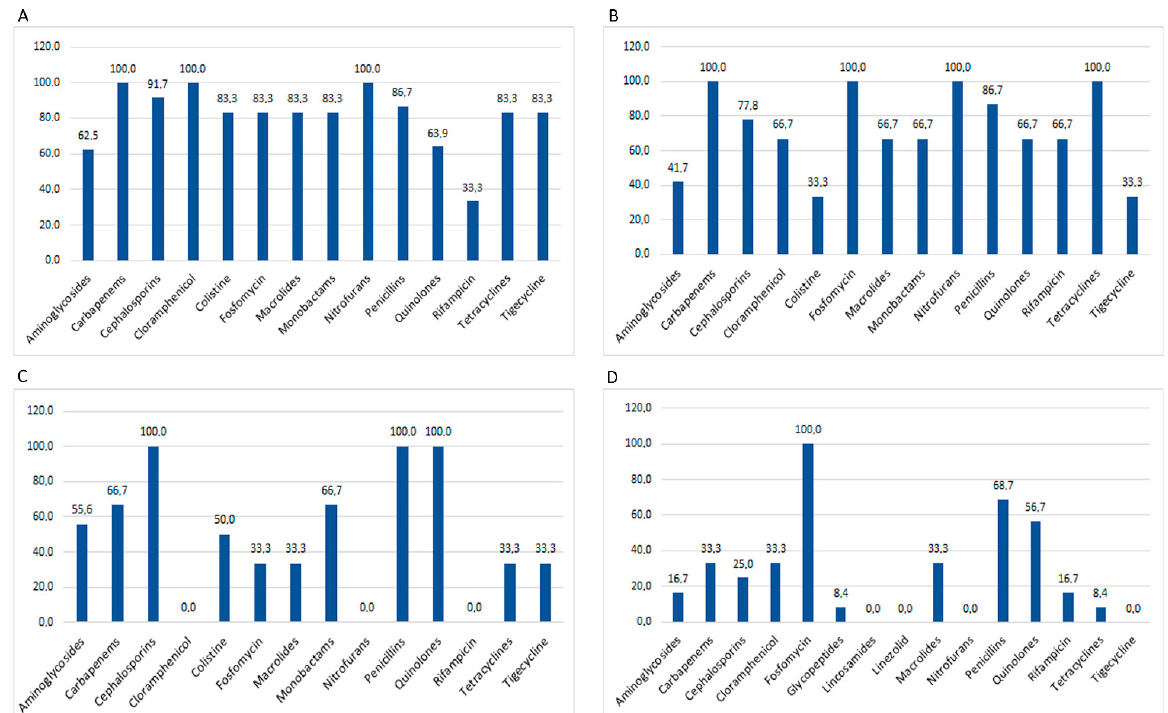
Figure 1. Values of the average percentage change ( Δ %) after treatment at 24 and 48 h against the strains, divided into Gram-positive and Gram-negative bacteria .